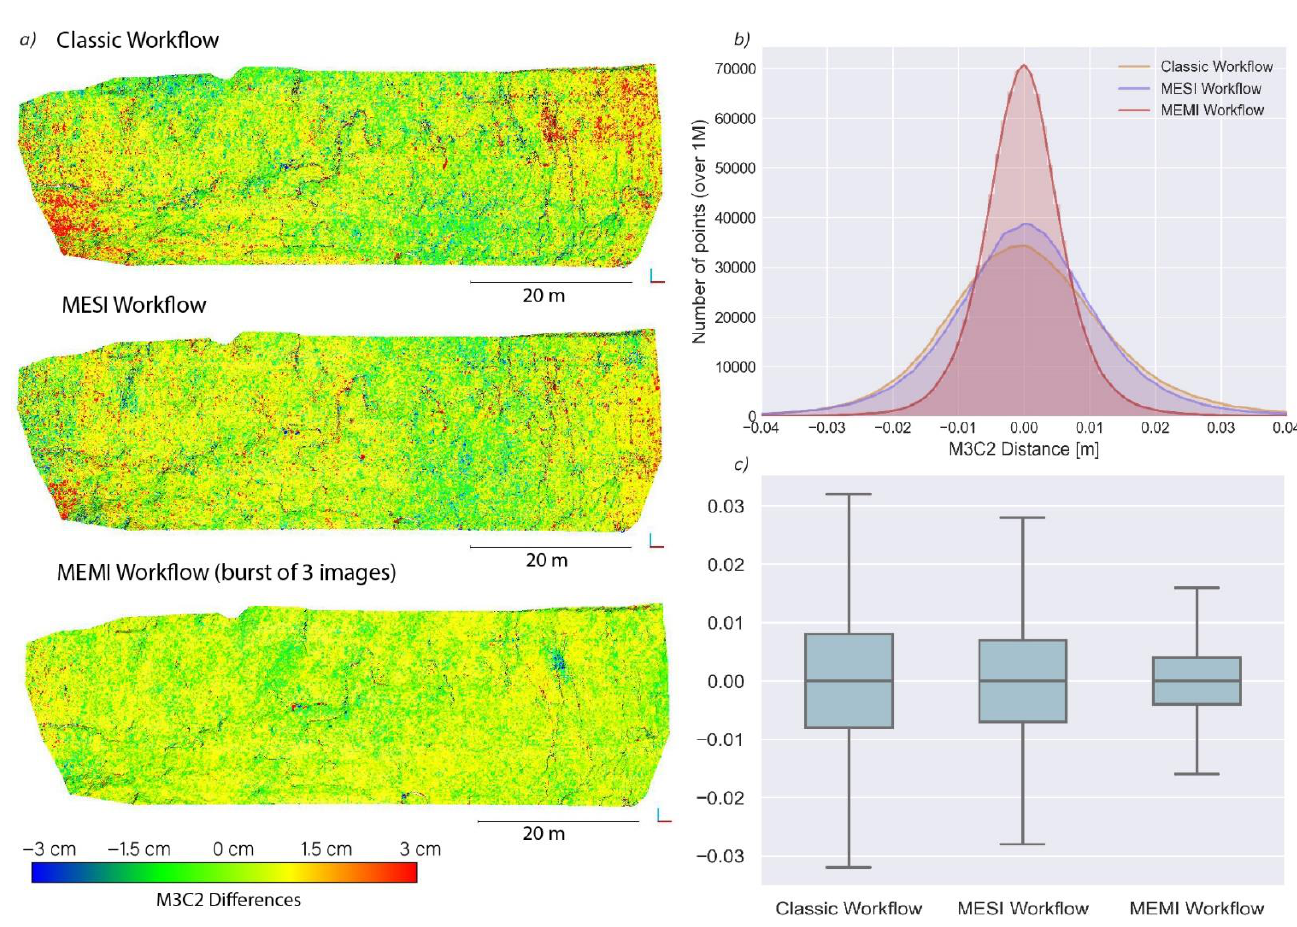
Figure 8. ( a ) Graphic representation of the differences between the models of November 8 and 13, according to the workflow used. The three models are represented with the same colour scale. ( b ) Histogram with the M3C2 results. ( c ) Error bar plot with the dispersion of the values obtained in each comparison.